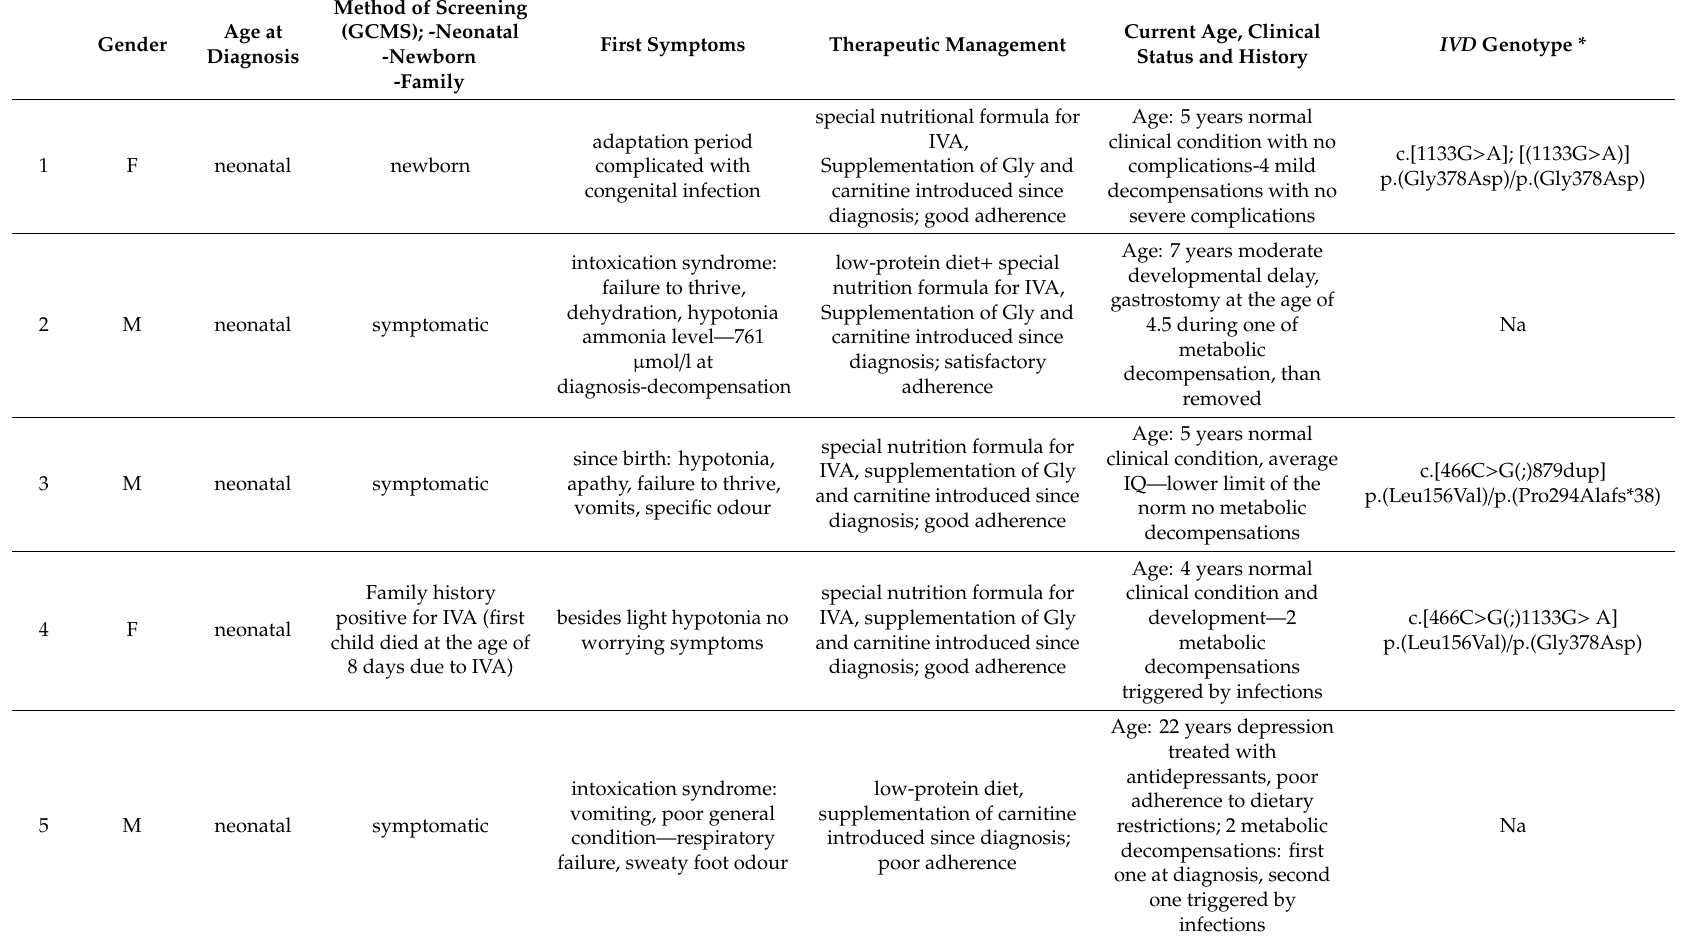
Table 1. Clinical and genotype data of 10 Polish patients with isovaleric acidemia